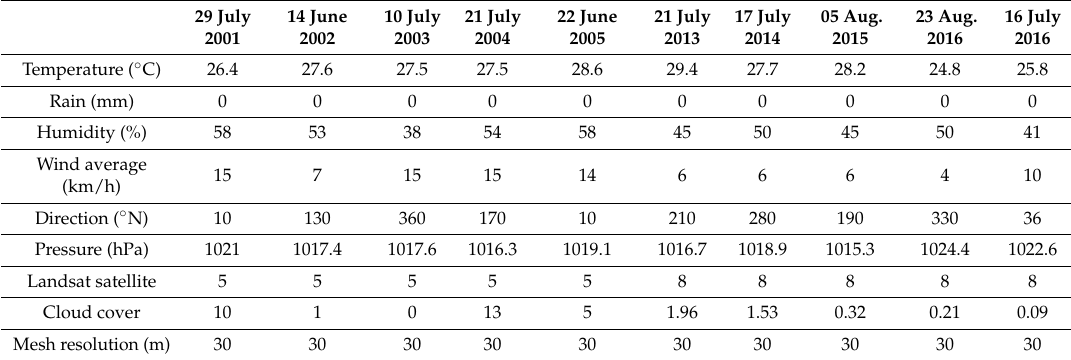
Table 1. Meteorological parameters of study days at the Lyon-Bron station at 12:00 (source: M é t é o-France).